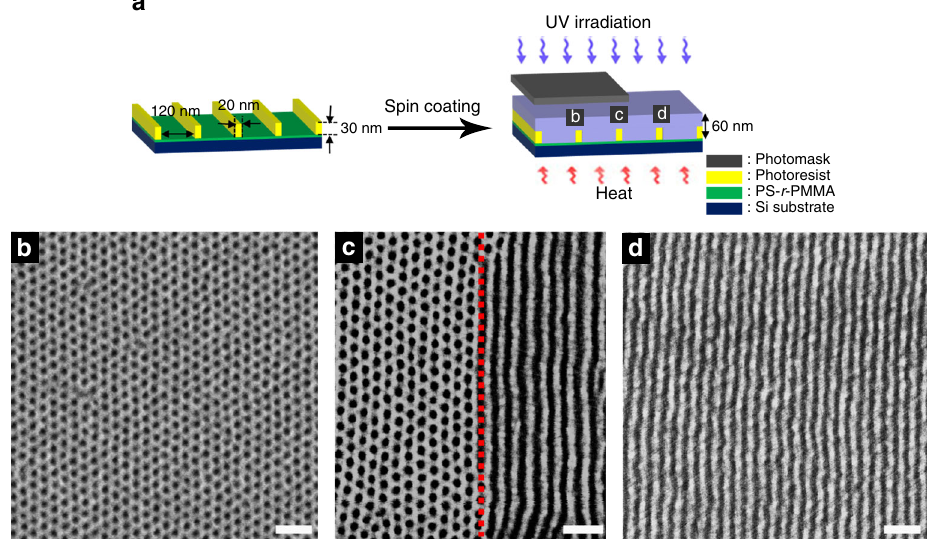
Fig. 5 Directed self-assembly of PS( hv -PS ′ )- b -PMMA after selective UV exposure. a Scheme of directed self-assembly using topologically pre-patterned substrate. SEM images of PS( hv -PS ′ )- b -PMMA on a patterned substrate at b unexposed, d exposed, and c boundary regions. Dark holes and lines in SEM images represent PMMA nanodomains that were etched out by O 2 RIE. The red dotted line represents the boundary. Scale bar is 100